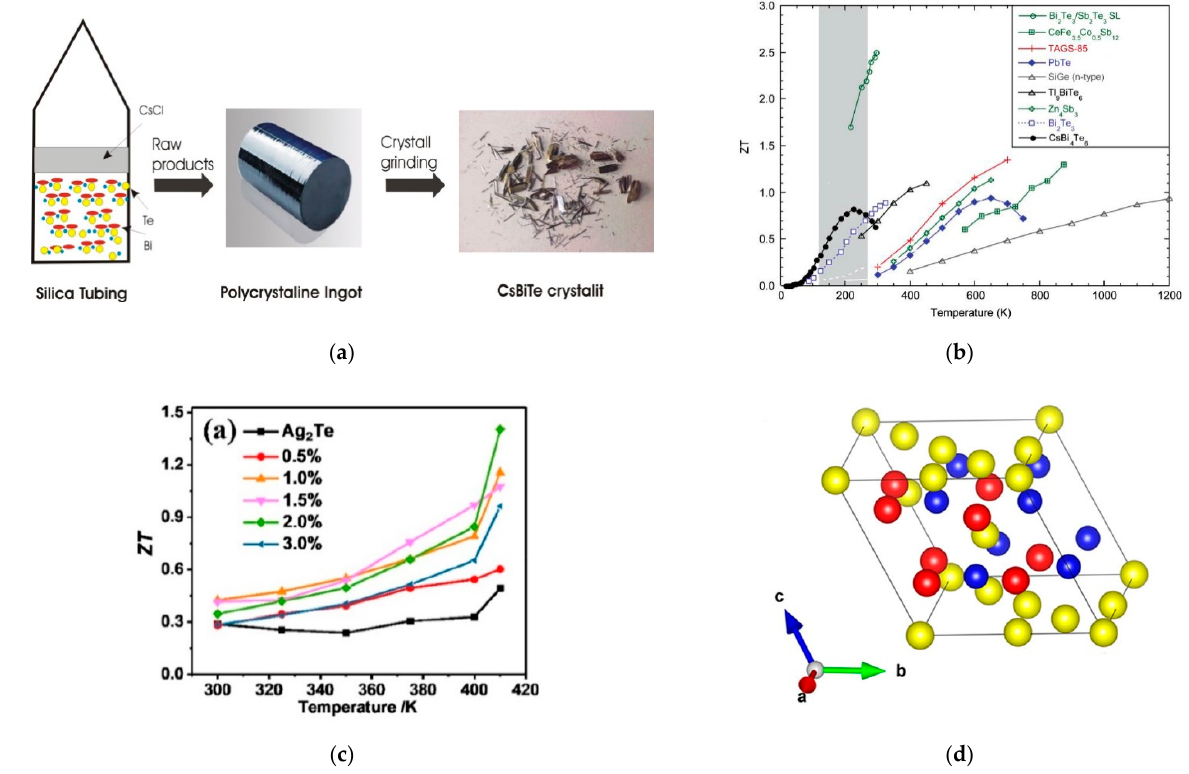
Figure 6. ( a ) The schematic synthesis process of CsBi 4 Te 6 crystals [143]. ( b ) ZT of thermoelectric materials as a function of temperature. In the shaded region, CsBi 4 Te 6 could possibly be available for thermoelectric applications. Reprinted with permission from [143]. ( c ) ZT value as a function of temperature for Ag 2 Sb x Te 1 − x samples. Reprinted with permission from [144]. ( d ) The crystal structure of α -MgAgSb. Reprinted with permission from [145]. Table 7. Properties of some other potential TE